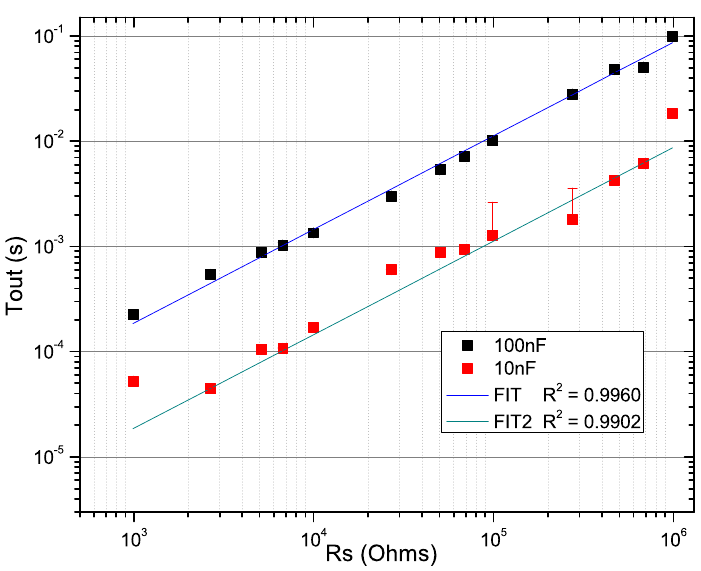
Figure 15. Measurement for different values of capacitance